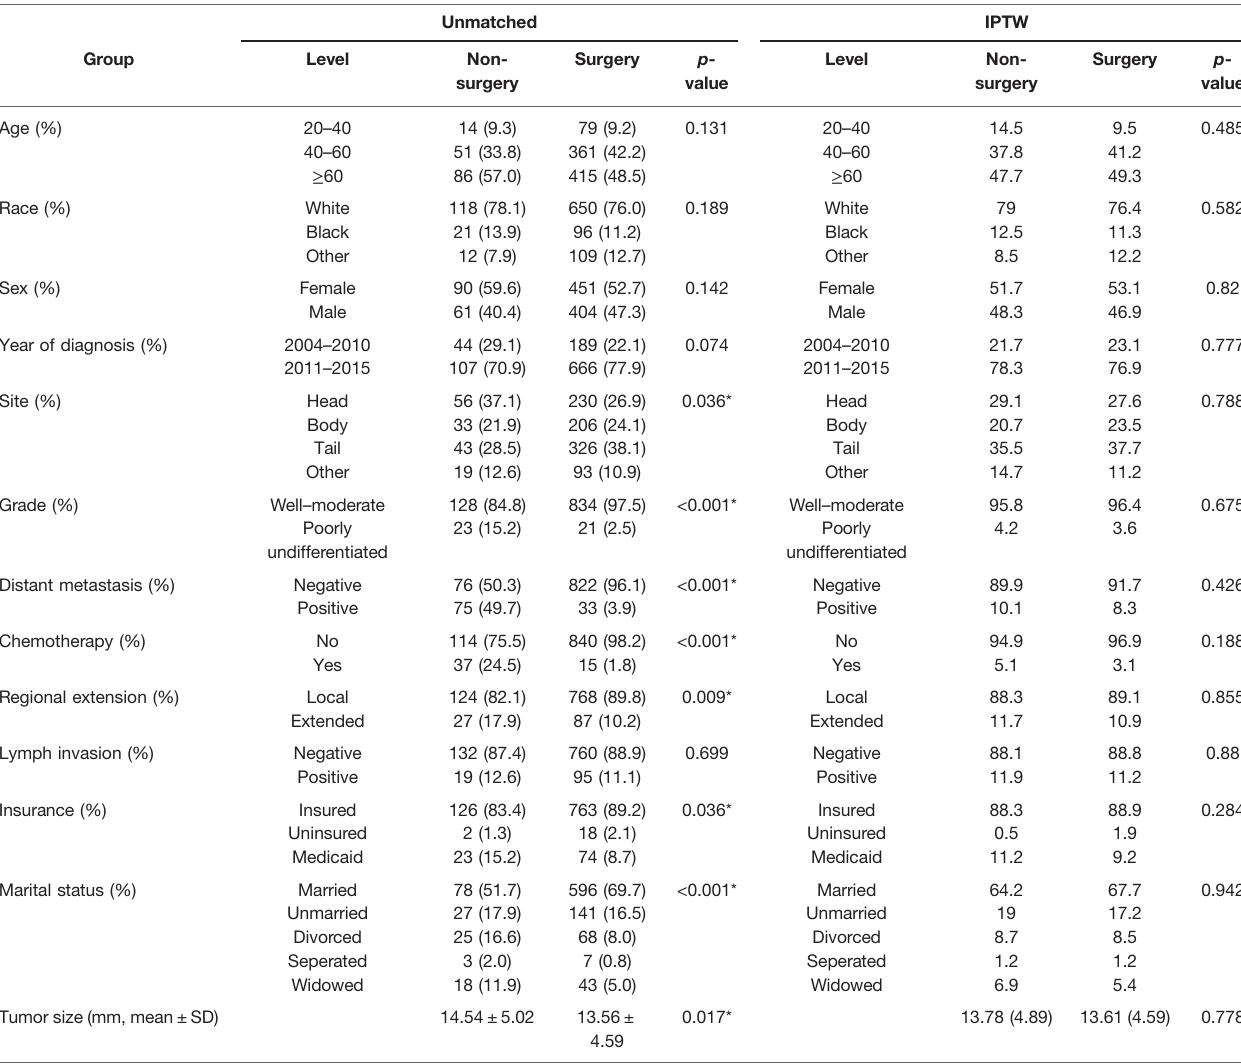
TABLE 2 | Comparison of baseline characteristics before and after